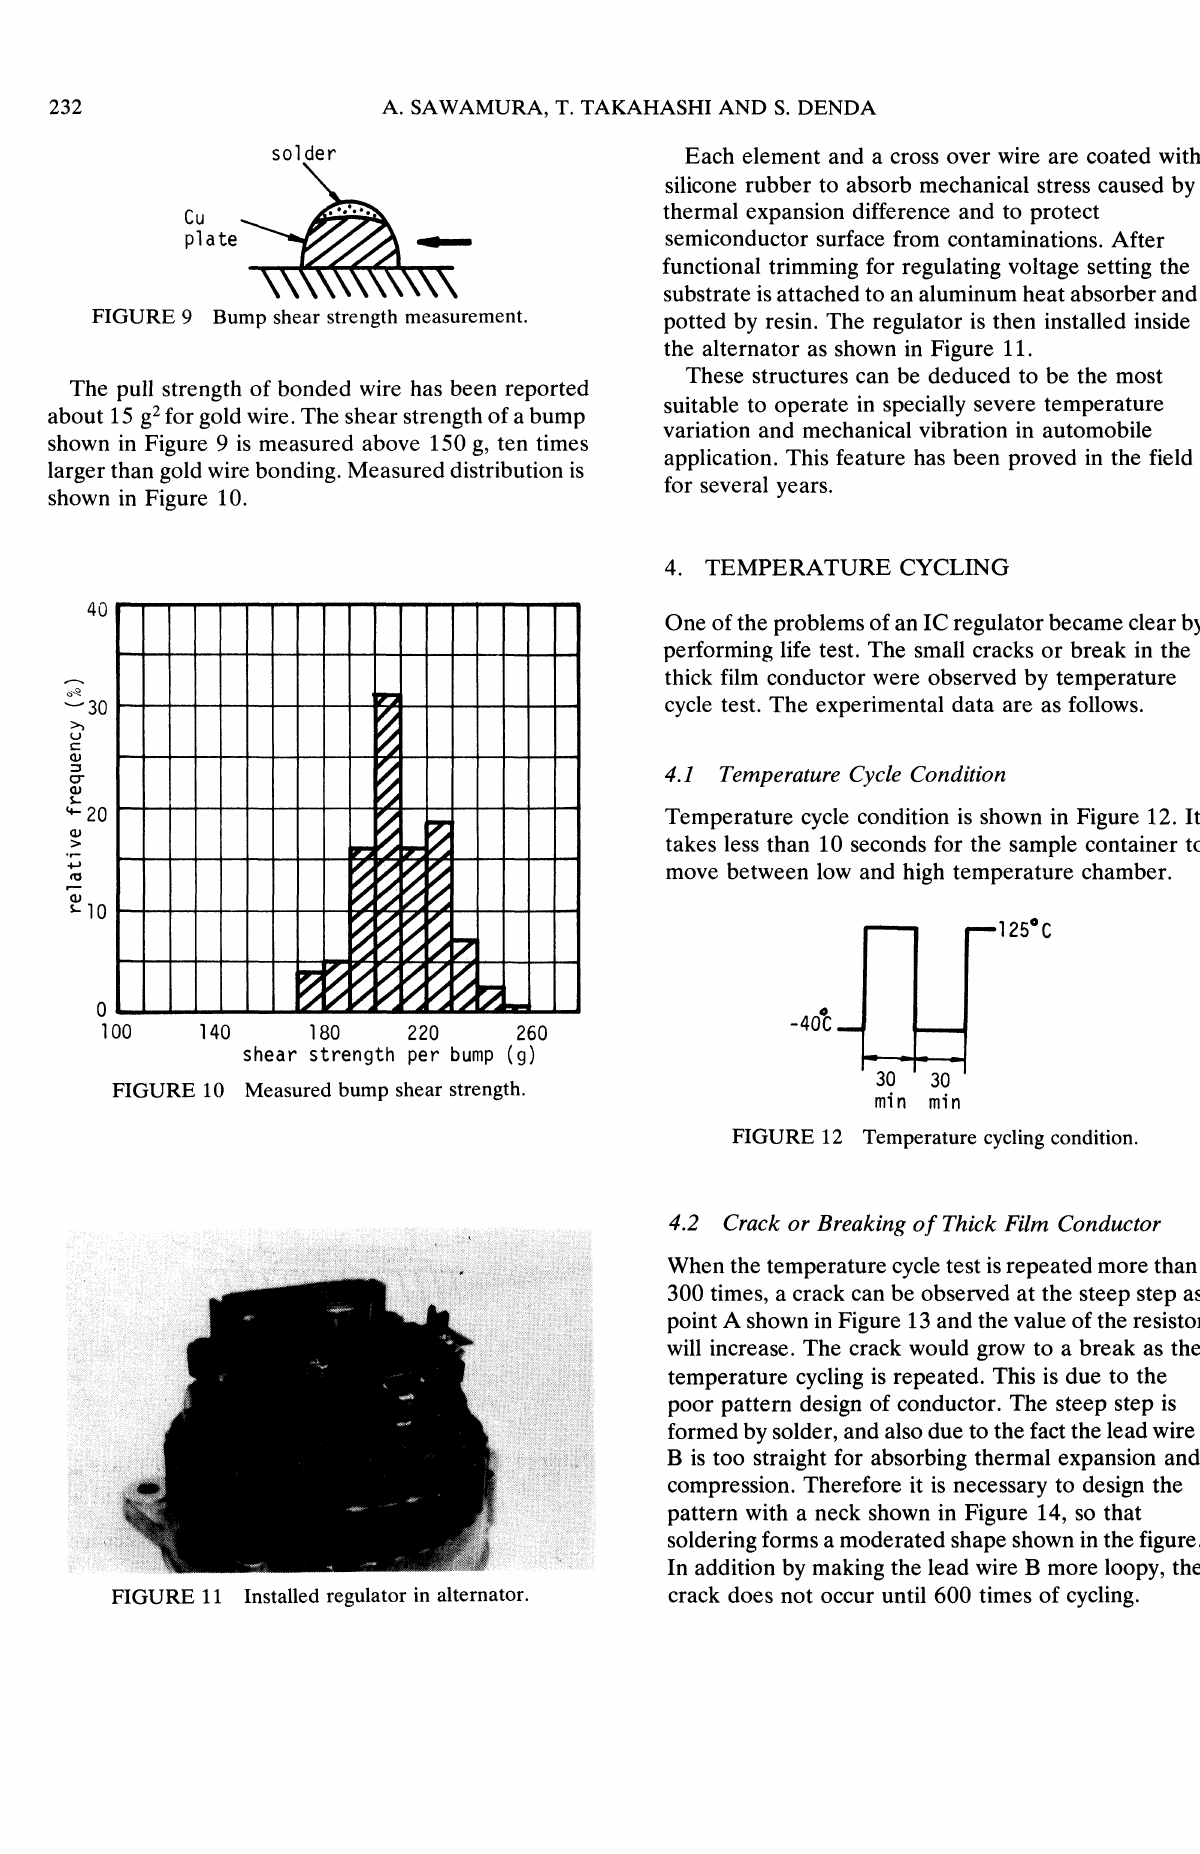
FIGURE 11 Installed regulator in